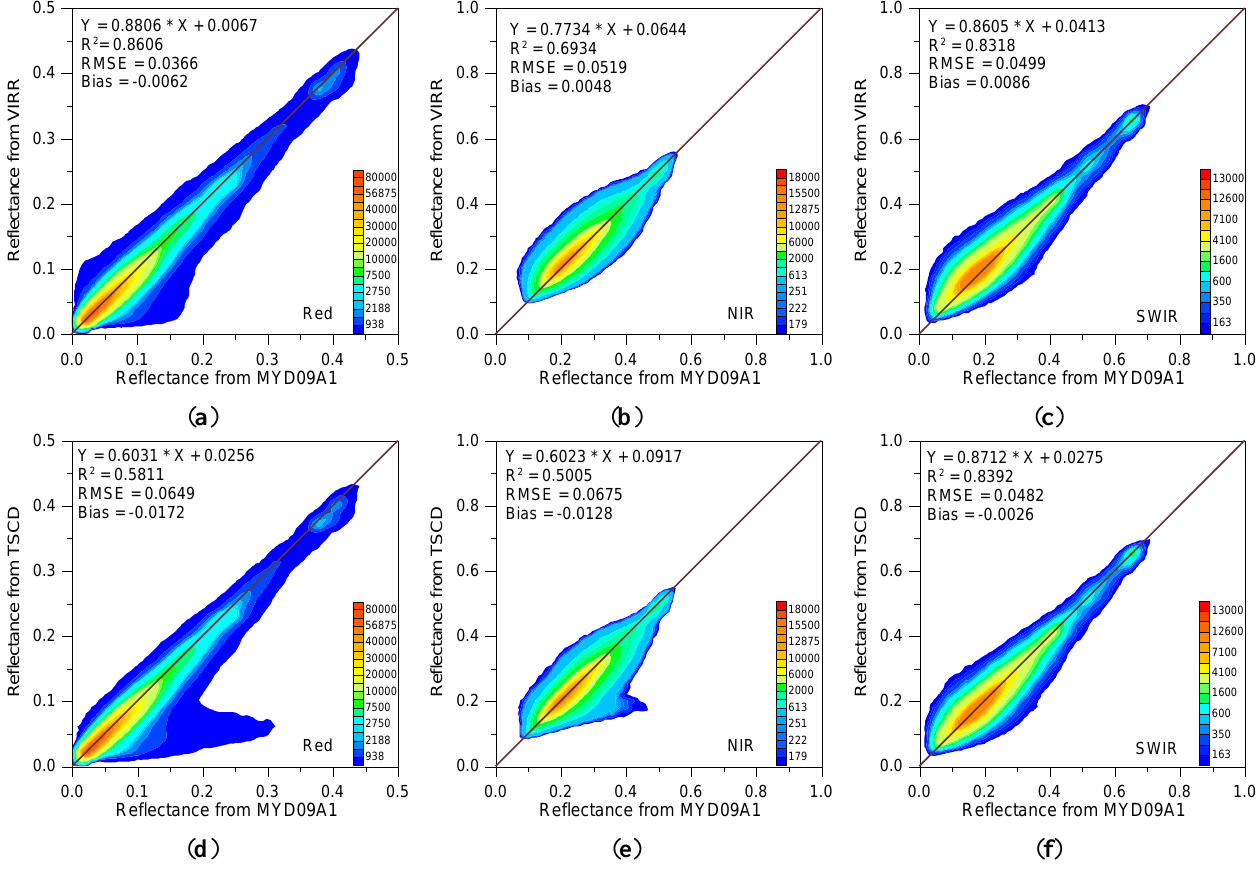
Figure 4. Density scatterplots between the cloud-free surface reflectance from MYD09A1 and the reconstructed surface reflectance from the VIRR (( a )–( c )) and TSCD (( d )–( f )) algorithms over the BELMANIP sites in